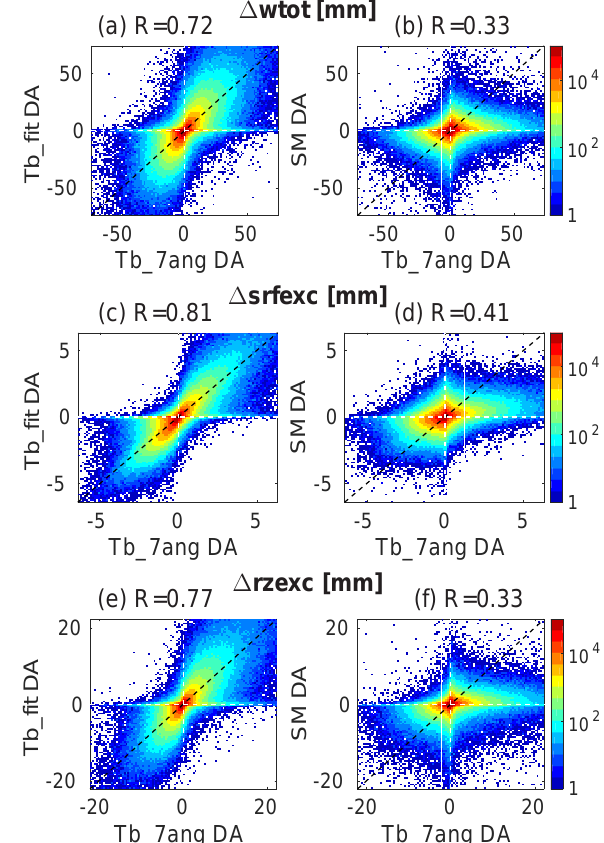
Figure 7. Spatially and temporally collocated analysis increments from ( a , c , e ) Tb_fit assimilation and ( b , d , f ) SM retrieval assim- ilation vs. the same from Tb_7ang assimilation for ( a , b ) profile- integrated wtot increments, ( c , d ) srfexc increments, and ( e – f ) rzexc increments. Increments are from the period 1 July 2010 to 1 May 2015. The plot range is limited to the maximum value of 10 times the standard deviation in either experiment, and divided into 100 even sample bins. Colors indicate the number of sample points within each 1.5, 0.13, or 0.44mmbin for (cid:49) wtot, (cid:49) srfexc, and (cid:49) rzexc, respectively. R is the spatio-temporal Pearson correlation coefficient between the individual increments from two assimilation